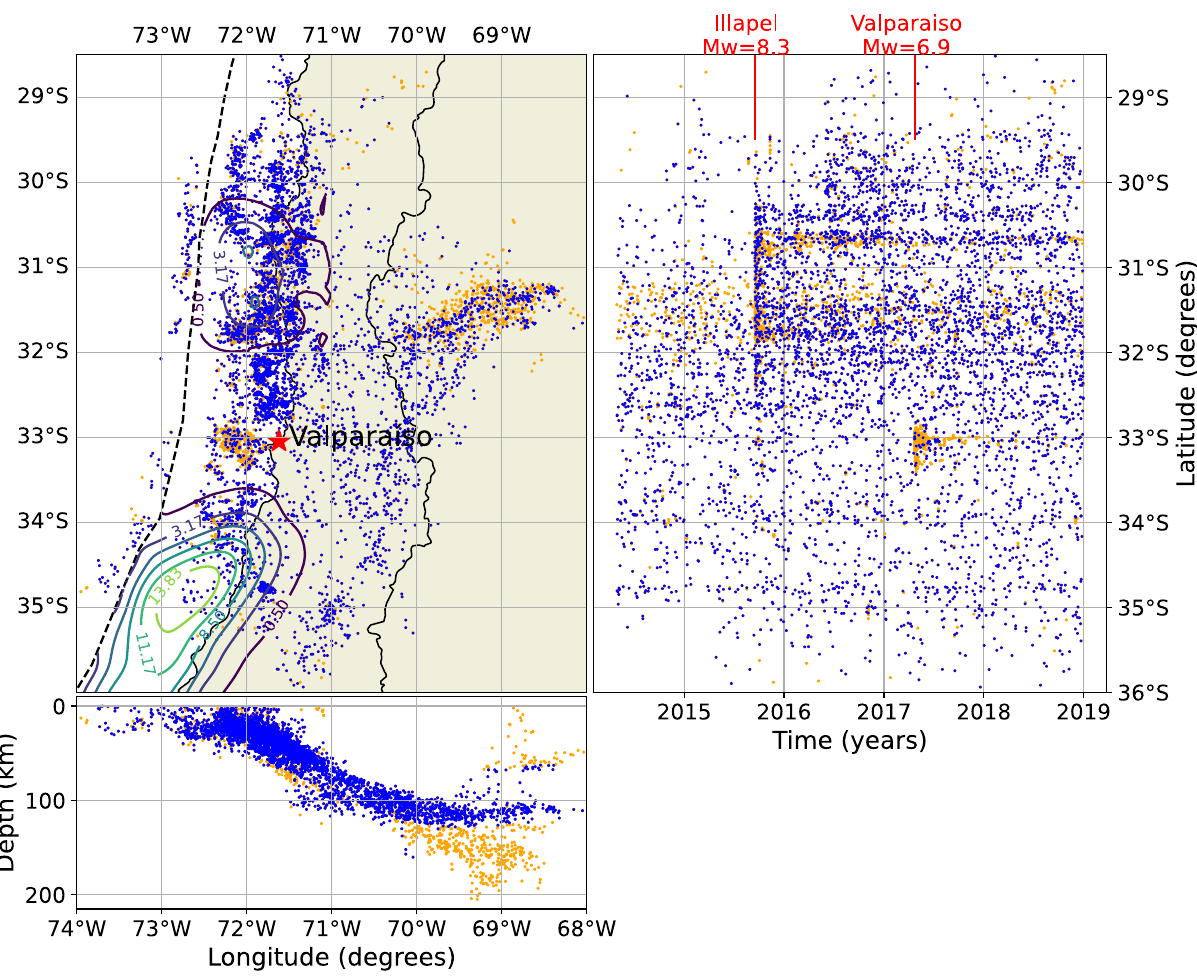
Figure 3. Spatial and temporal analysis of the seismicity catalog used in the present study. The colors indicate background seismicity (blue) and dependent events (orange). Dashed lines indicate the position of the trench, and solid lines trace slip contours of the 2015 Illapel earthquake ( M w = 8.3 ) 22 and the 2010 Maule earthquake ( M w = 8.8 ) 23 . The red star indicates the position of Valparaíso. Red lines shows the position in time of the 2015 Illapel earthquake and the 2017 Valparaiso earthquake ( M w = 6.9 ) 49 . This figure was created using Python 3.8.13 50 , Matplotlib 3.5.2 51 and Cartopy 0.21.0 52